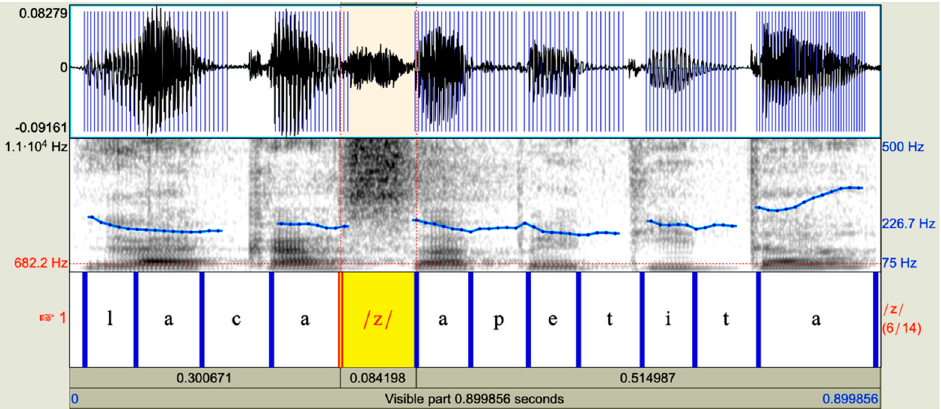
Figure 1. Younger L1-Catalan female rendition of la ca / z / a petita (‘the little house’) in Valencian Catalan (~9% voiced).